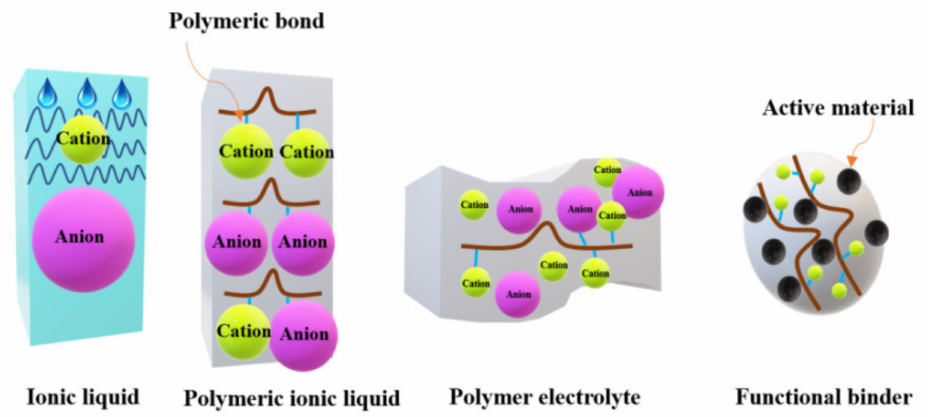
Figure 1. A schematic representation of ionic liquids, polymeric ionic liquids, polymer electrolytes, and functional